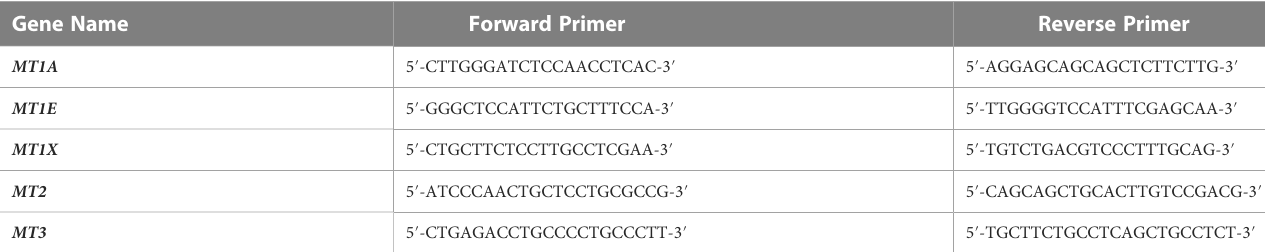
TABLE 1 Table of primer sequences.